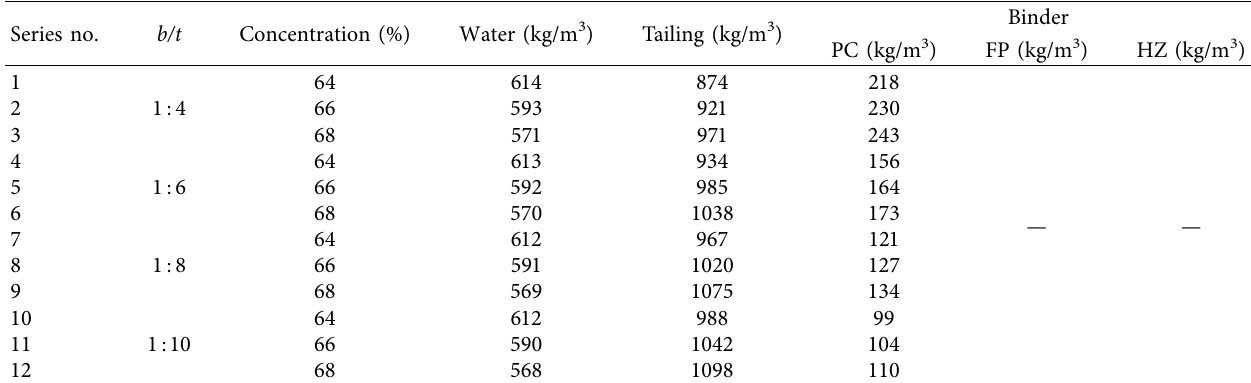
Table 5: Mix proportion of the filling